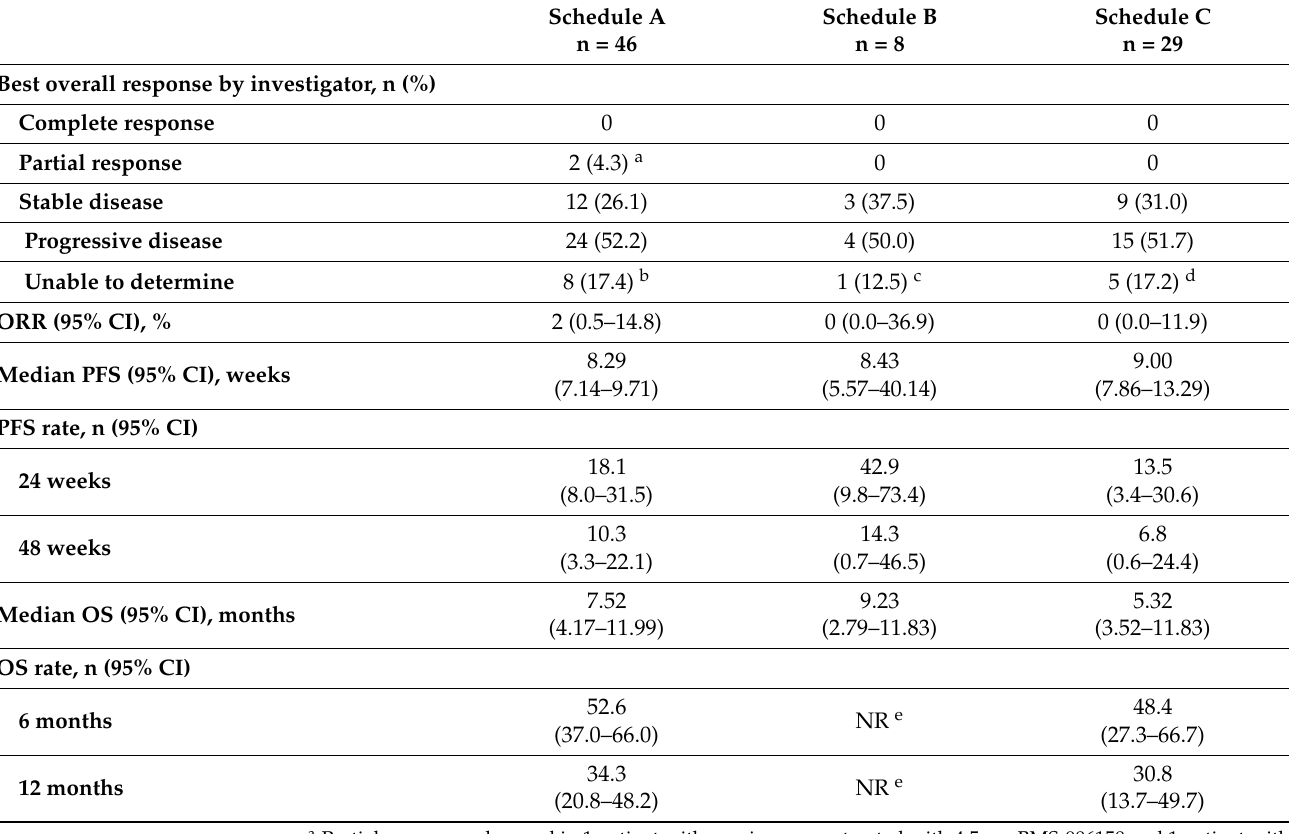
Table 4. Preliminary efficacy by dosing